Question: How would you classify this visualization?
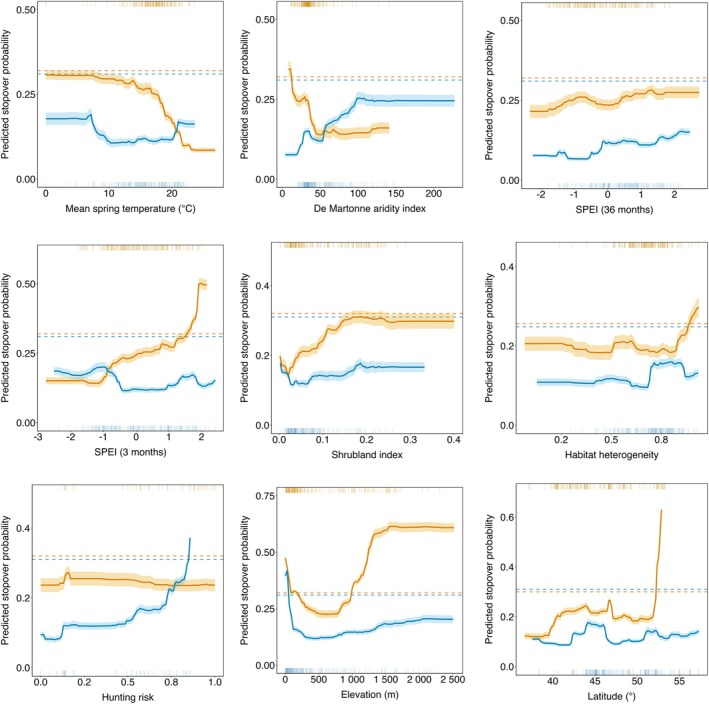
Answer: line